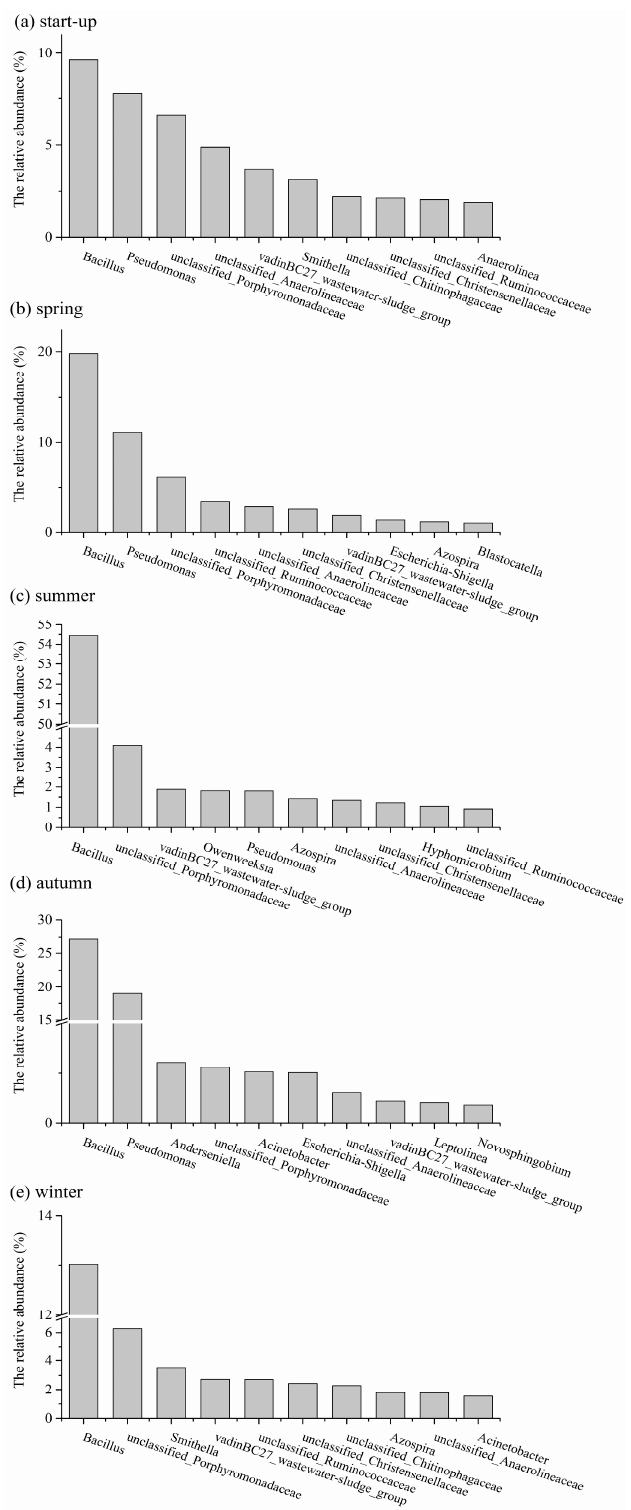
Figure 10. The top 10 bacterial genera during ( a ) start ‐ up; ( b ) spring; ( c ) summer; ( d ) autumn; ( e ) winter period.